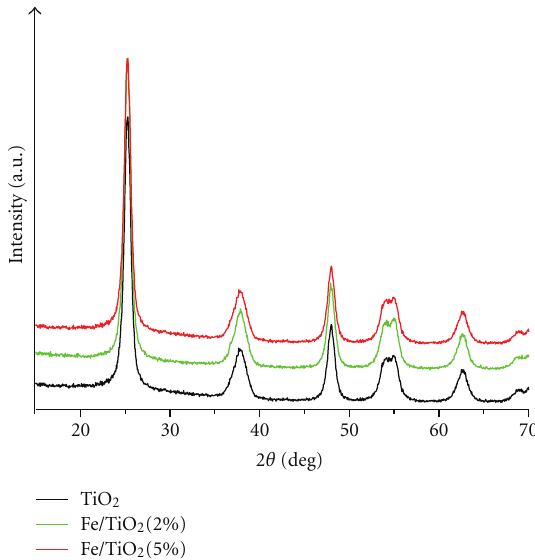
Figure 2: The XRD patterns of TiO 2 nanoparticles and Fe-doped TiO 2 nanocomposites calcined at 400 ◦